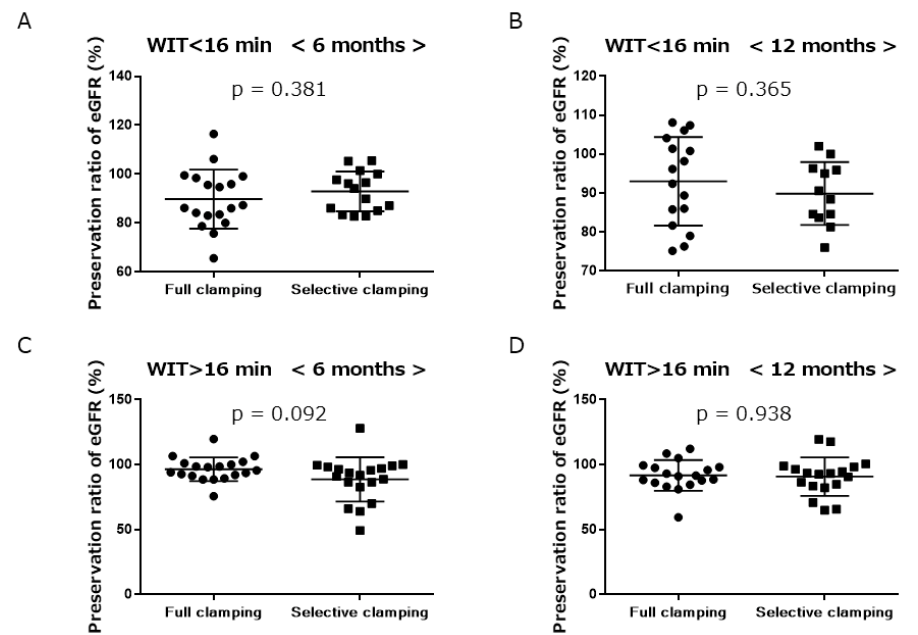
Figure 3. Preservation ratio of eGFR. Category of WIT<16 min (( A ) 6 months, ( B ) 12 months). Category of WIT>16 min (( C ) 6 months, ( D ) 12 months). Full clamping vs. selective clamping, mean with standard deviation.